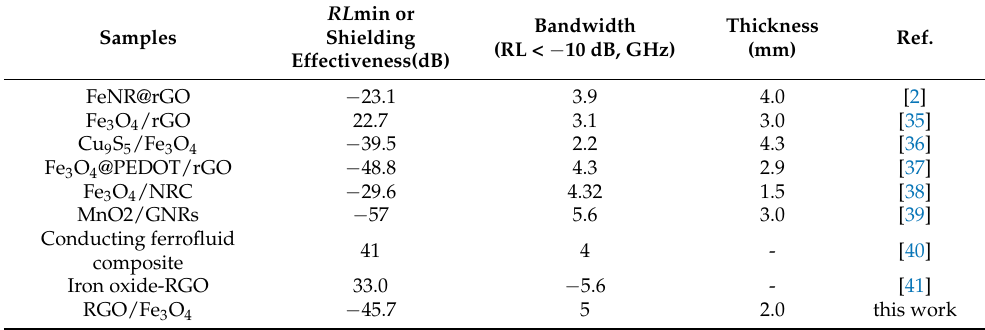
Table 1. The electromagnetic wave absorption or shielding property of relative absorbers.